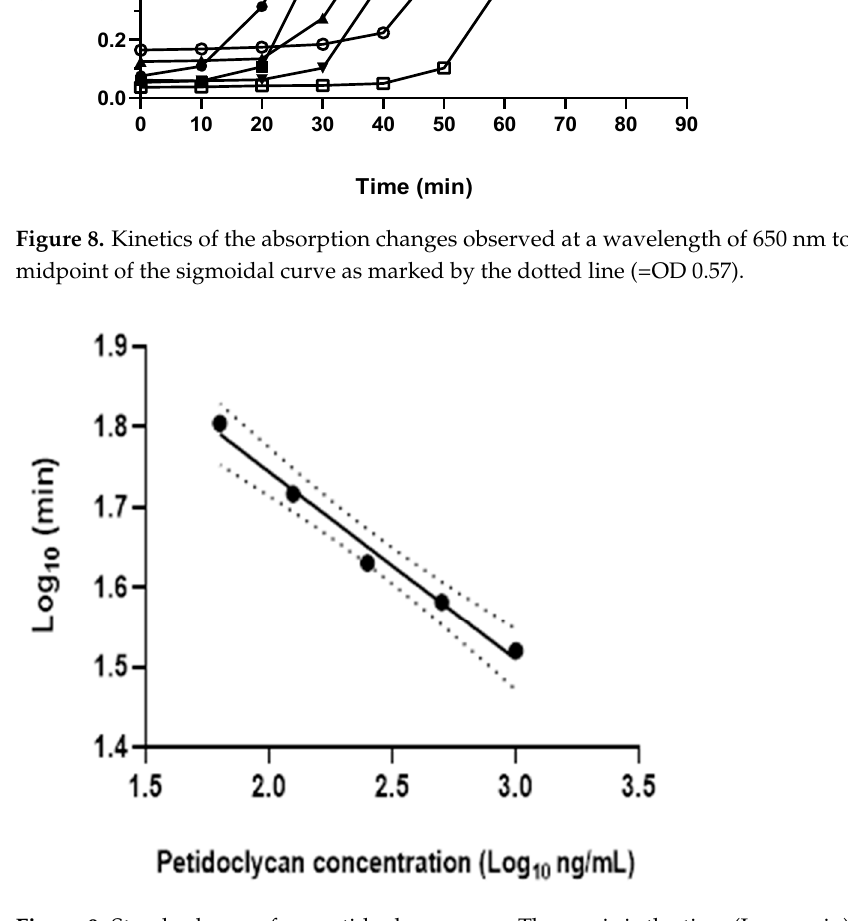
Figure 9. Standard curve for peptidoglycan assay. The y axis is the time (Log 10 min) till the diluted standard reached the mid-point of the sigmoidal curve, plotted against the log of the concentration of peptidoglycan in that standard (PGN; Log 10 ng/mL).